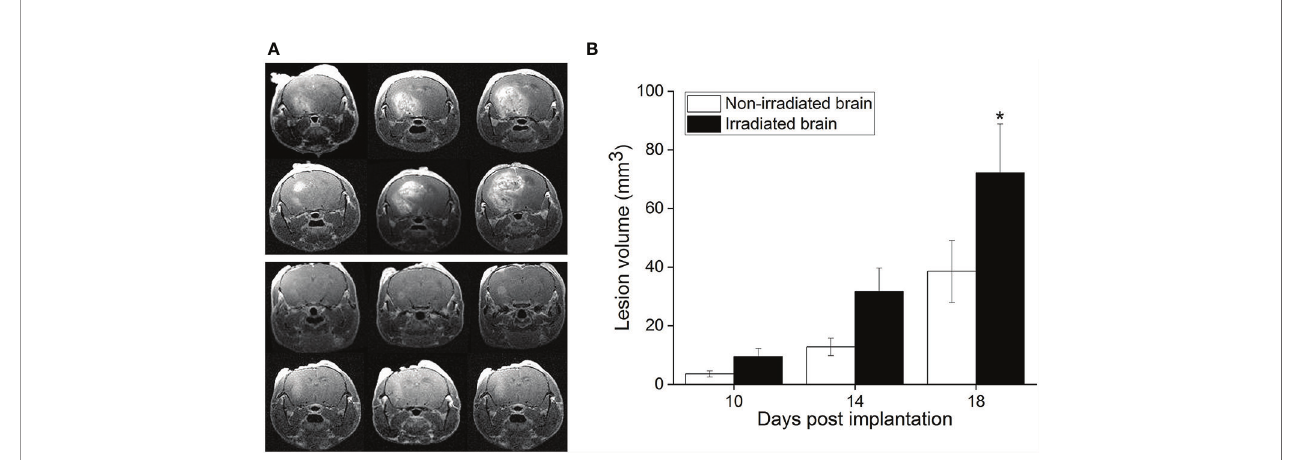
FIGURE 1 | (A) Representative, contrast-enhanced T1-weighted MR images of GL261 tumor-bearing C57Bl/6 mice, collected 18 days after tumor implantation. The top panel shows three contiguous image slices for two animals whose brains were focally irradiated with 30-Gy (50% isodose) Gamma Knife radiation six weeks prior to GL261 cell implantation in the RI 2 M. The bottom panel shows similar images for non-irradiated mice. Tumors growing in the RI 2 M are larger and more hyperintense (re fl ecting greater leakage of contrast agent) compared with tumors growing in non-irradiated brain. (B) Plots showing mean lesion volume (+/- SEM) for tumors growing in irradiated (n = 9; black) and non-irradiated (n = 10; white) brain at post-implantation days 10, 14, and 18. At post-implantation day 14, there is a trend toward larger lesion volumes in irradiated brain (p = 0.07). At post-implantation day 18, the difference in lesion volumes is statistically signi fi cant (*p = 0.030).